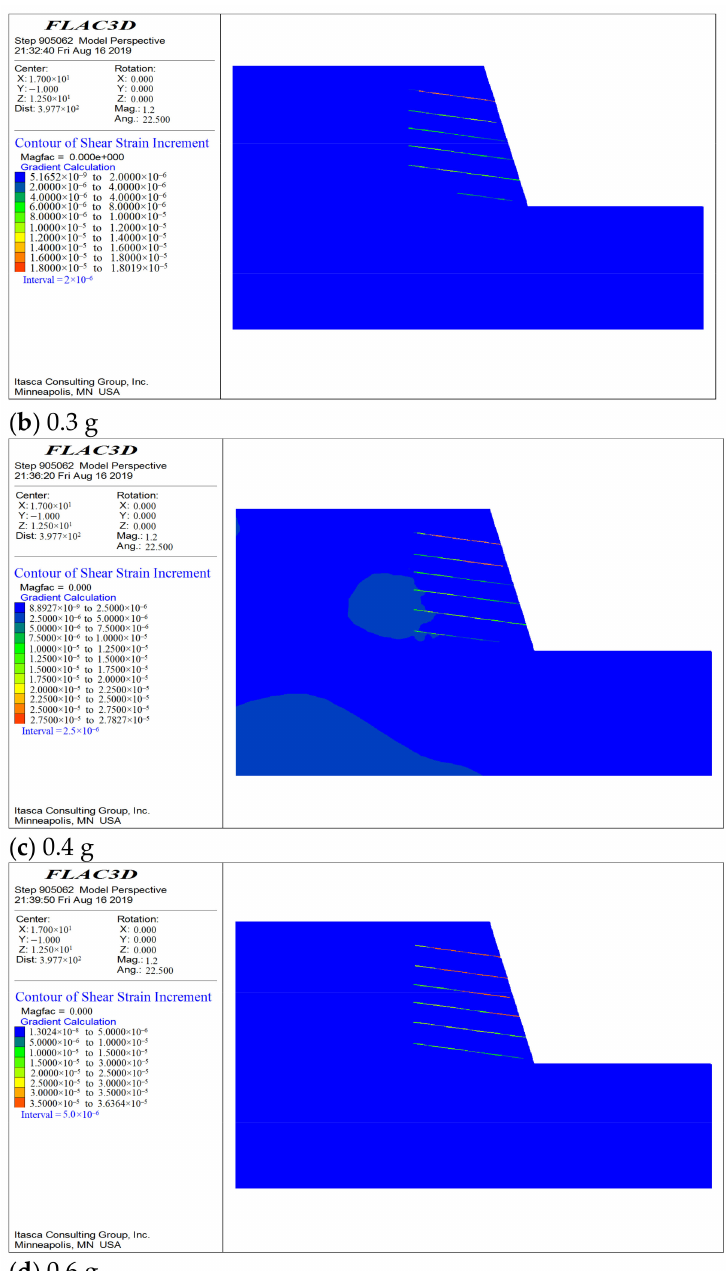
Figure 16. Contours of the shear strain increment in the weak zone subject to the WE